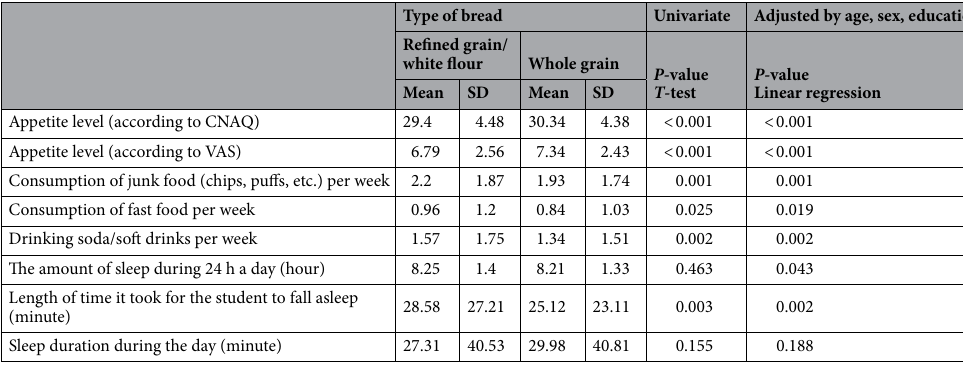
Table 5. The relationship between appetite level, consumption of fast food, and sleep quality with the type of bread in the students. CNAQ, Council of Nutrition Appetite Questionnaire; VAS, visual analog